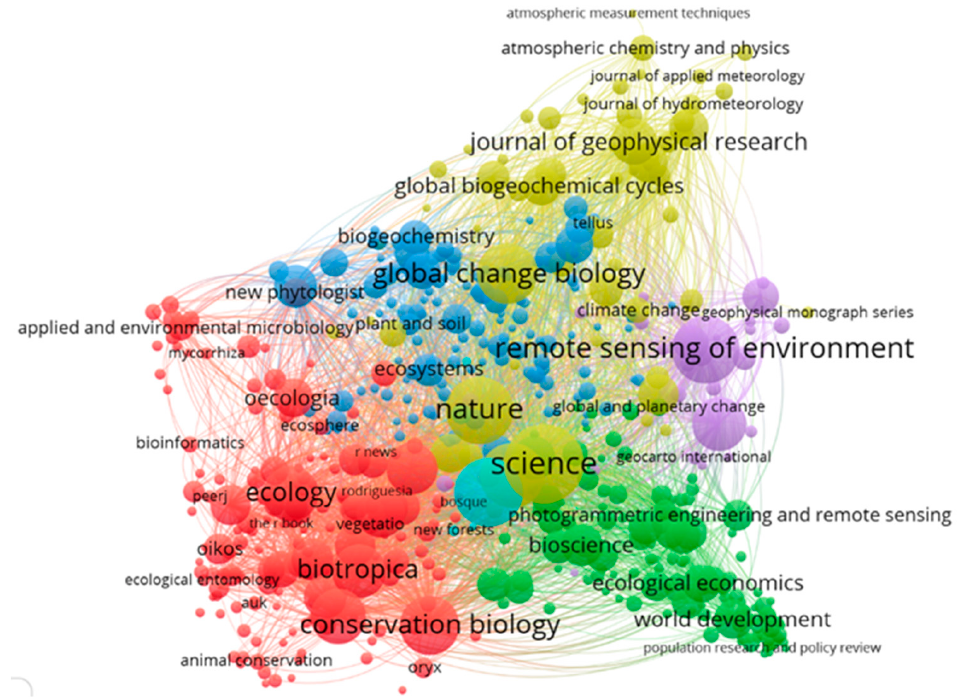
Figure 6. Network and grouping of co-cited journals. Clusters of the same color represent areas of knowledge.